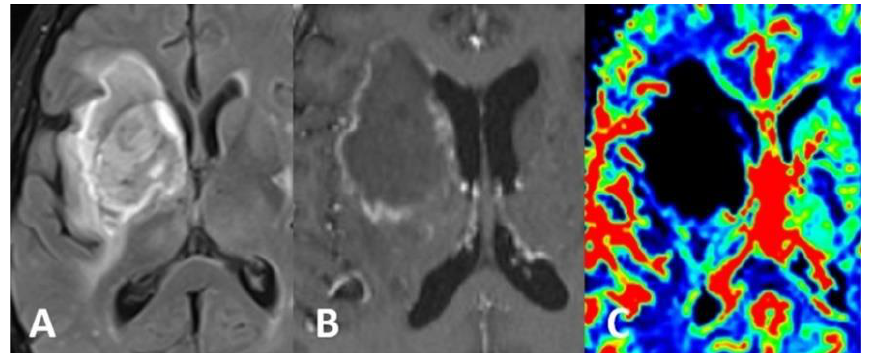
Figure 2. MRI of the brain showed a heterogeneous lesion on the T2/FLAIR sequence ( A ), displaying ring-enhancement after gadolinium injection ( B ). Perfusion-weighted imaging showed significant decrease of CBV ( C ) within the lesion.